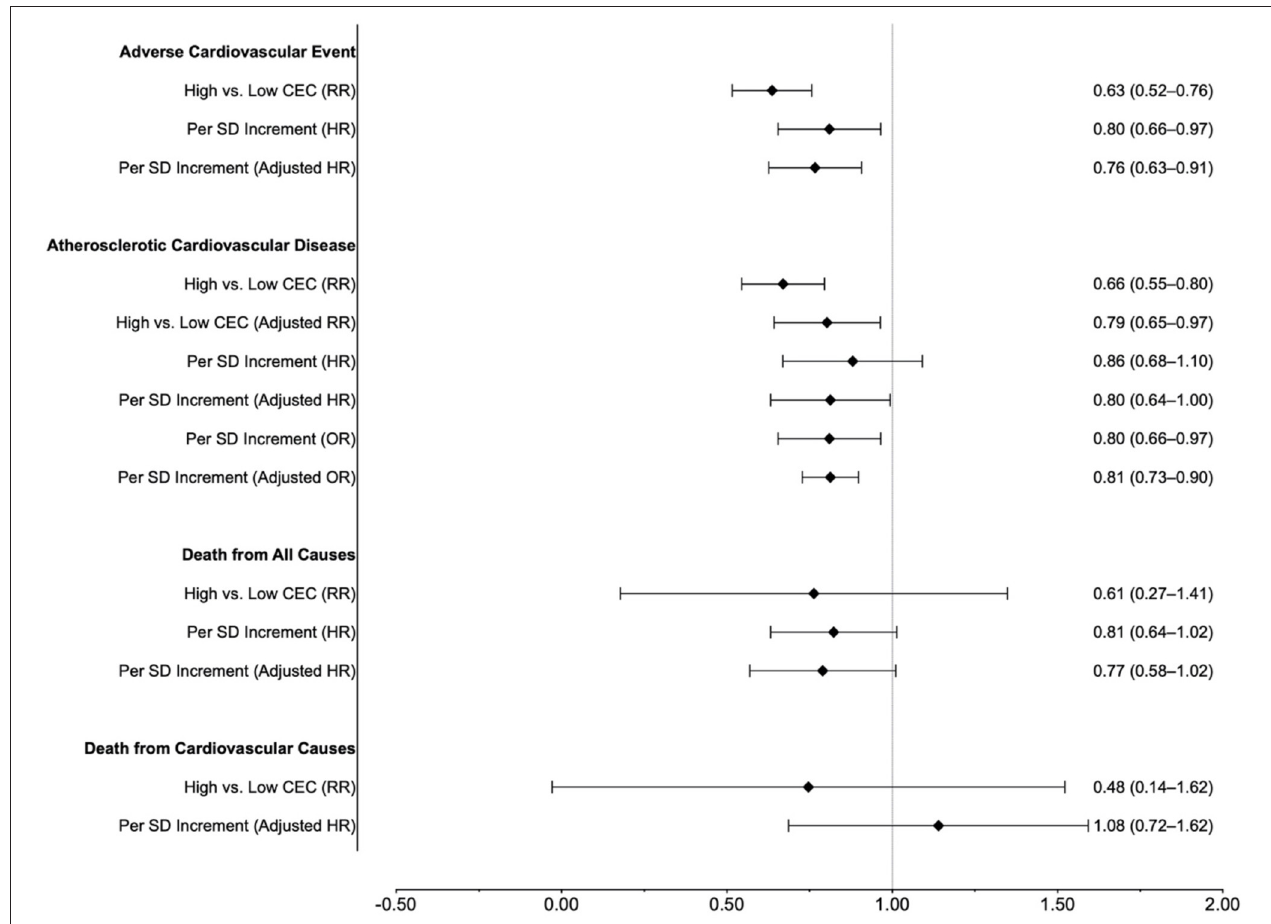
FIGURE 5 | Summary of